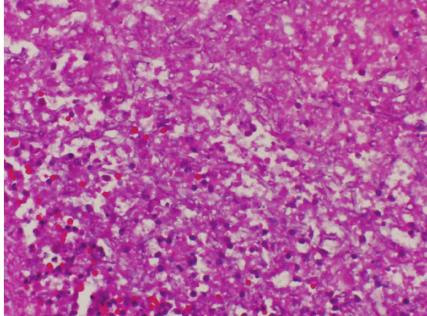
Figure 1: Operatively obtained jejunal tissue section from Patient 3, showing multiple broad hyphae (hematoxylin and eosin, original magnification 400x).